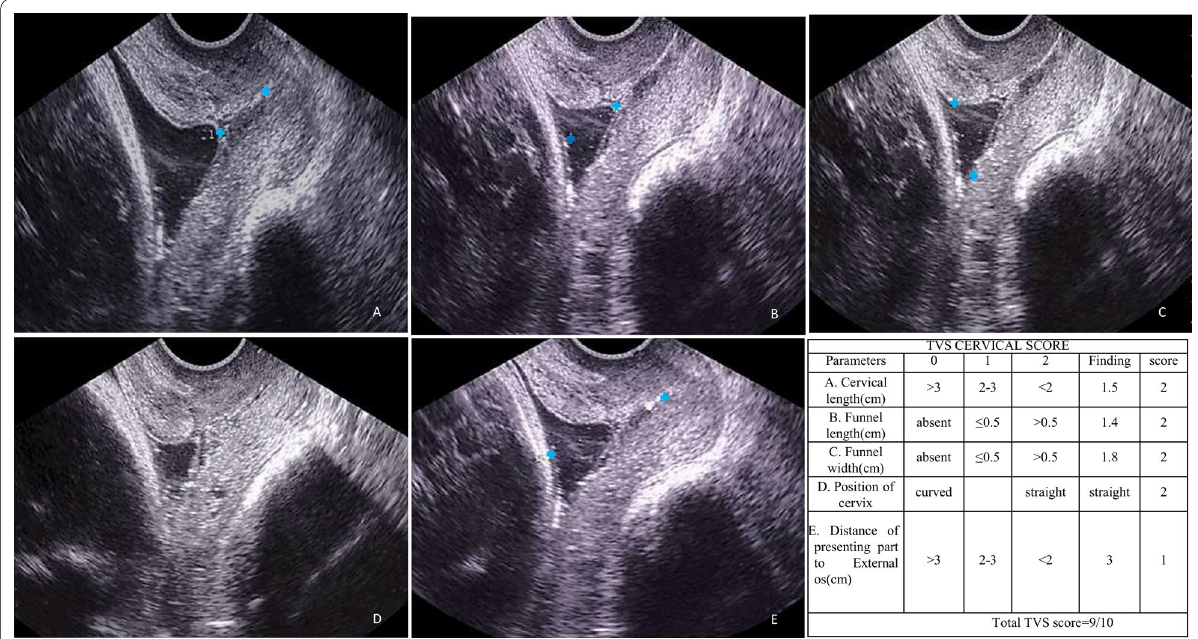
Fig. 4 A 20-year-old female with gestational age of 40 weeks who admitted for induction of labour, and her Bishop score was 4, on TVS examination shows A cervical length-1.5 cm, B funnel length-1.4 cm, C funnel width-1.8 cm, D position of cervix-straight, E distance of presenting part to external os-3 cm constituting TVS score of 9/10 undergone successful labour induction even if Bishop score was